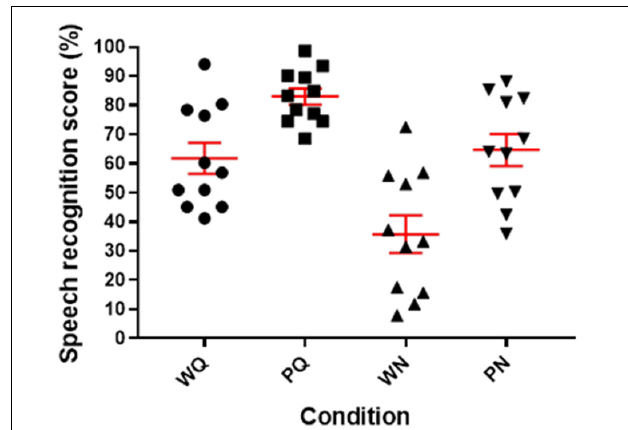
( Figure 4 ), an LME analysis was conducted with defined fixed effects of Condition (Quiet, Noise), Time-window (3: Background, Peak, Retention interval) and a random intercept for patients. The model describes a main effect of Condition ( F -value = 32.45, p < 0.0001) and a main effect of Time- window ( F -value = 212.65, p < 0.0001) but no significant interaction ( F -value = 1.87, p = 0.15). In Quiet condition, post hoc pairwise analyses revealed that mean dilation was higher at peak window in comparison to background and retention